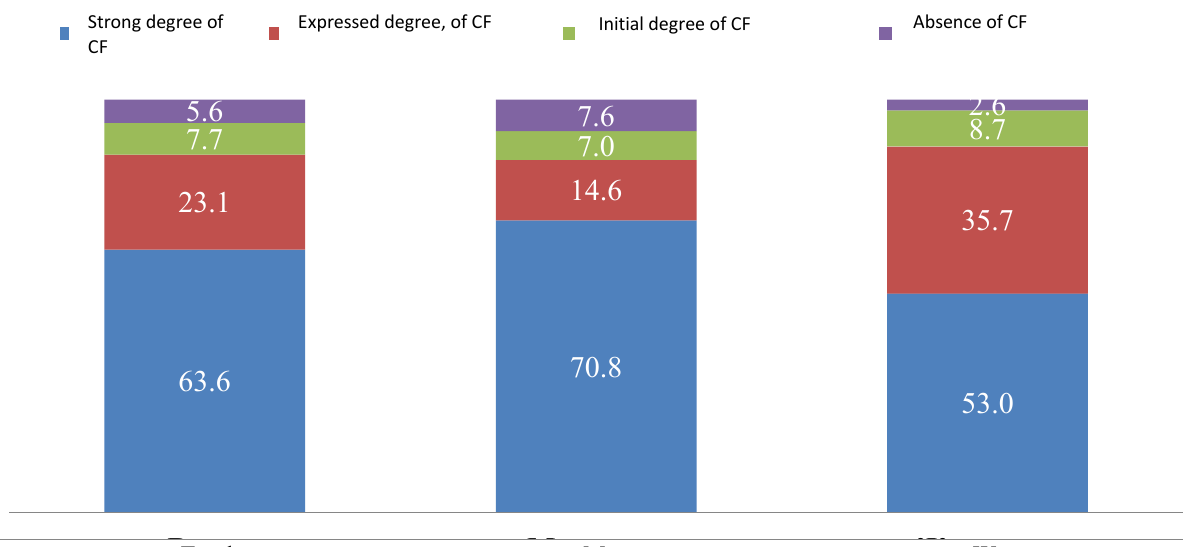
Total, Men, Women Fig. 1. Symptoms of chronic fatigue of different degree in the questioned sportsmen in general and separately among men and